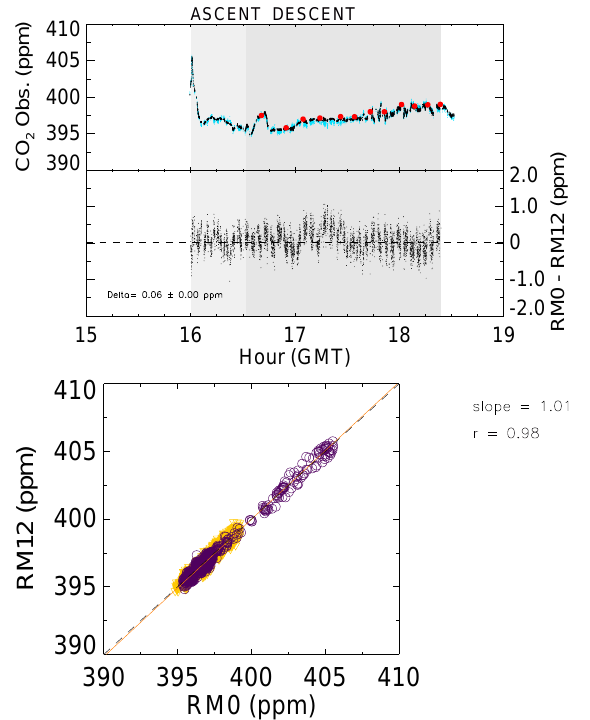
Fig. 7. CO 2 mole fraction collected using multiple technolgies (RM0, RM12, and PFP) during an 28 April 2011 flight. The top panel shows the time series of CO 2 mole fraction measured us- ing all three systems. The middle panel shows the mean difference (0.06ppm) between CO 2 mole fraction measured using the two rack mount systems. The standard deviation of the difference is 0.3ppm. The bottom panel shows a regression of the observations made us- ing RM0 and RM12 systems. Open purple and yellow circles cor- respond to the ascent and descent parts of the flight, respectively.